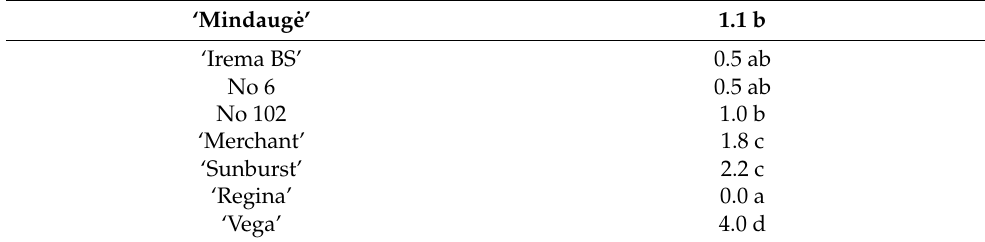
Table 2. Sweet cherry flower damage after winter 2021 (0–5 score scale). Values marked with different letters are statistically different within the columns ( p ≤ 0.05).